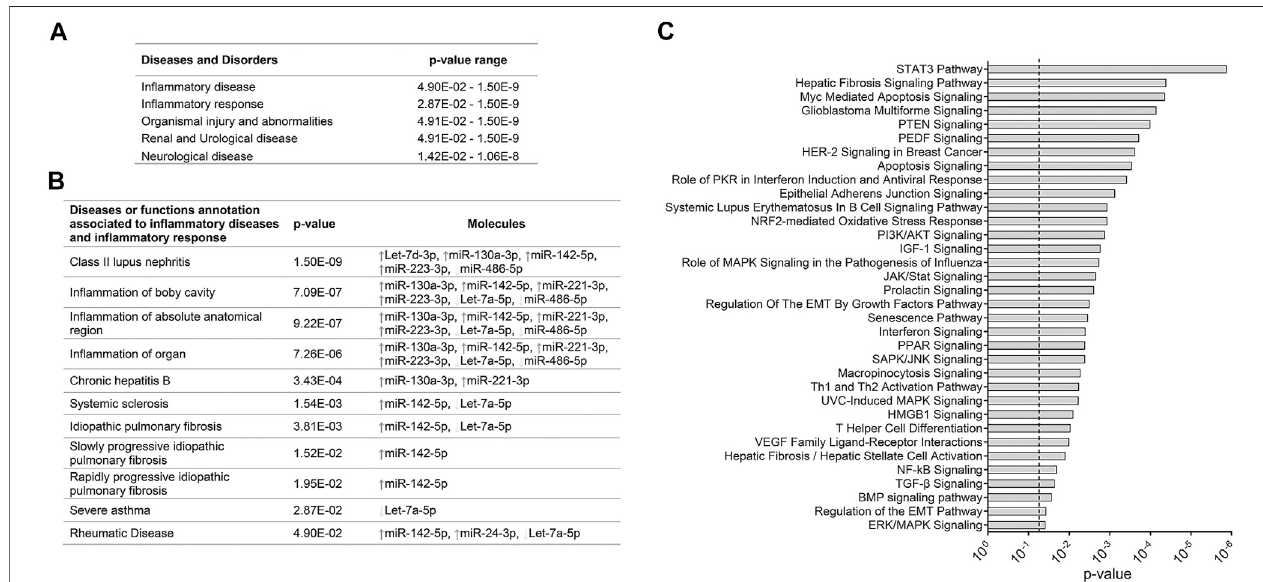
FIGURE 2 | Canonical pathways associated with exosomal miRNAs altered in the plasma of ARDS patients. (A) Diseases and disorders associated with ARDS- exosomal miRNAs. (B) Disease or function annotation related to in fl ammatory response associated with ARDS-exosomal miRNAs. (C) Canonical pathways associated with ARDS-exosomal miRNAs. Seven ARDS-related miRNAs that showed robust changes ( fi ve upregulated miRNAs: miR-142-5p, miR-122-5p, miR-223-3p, Let-7d- 3p, and miR-24-3p, and two downregulated miRNAs: Let-7a-5p and miR-486-5p) were subjected to the IPA